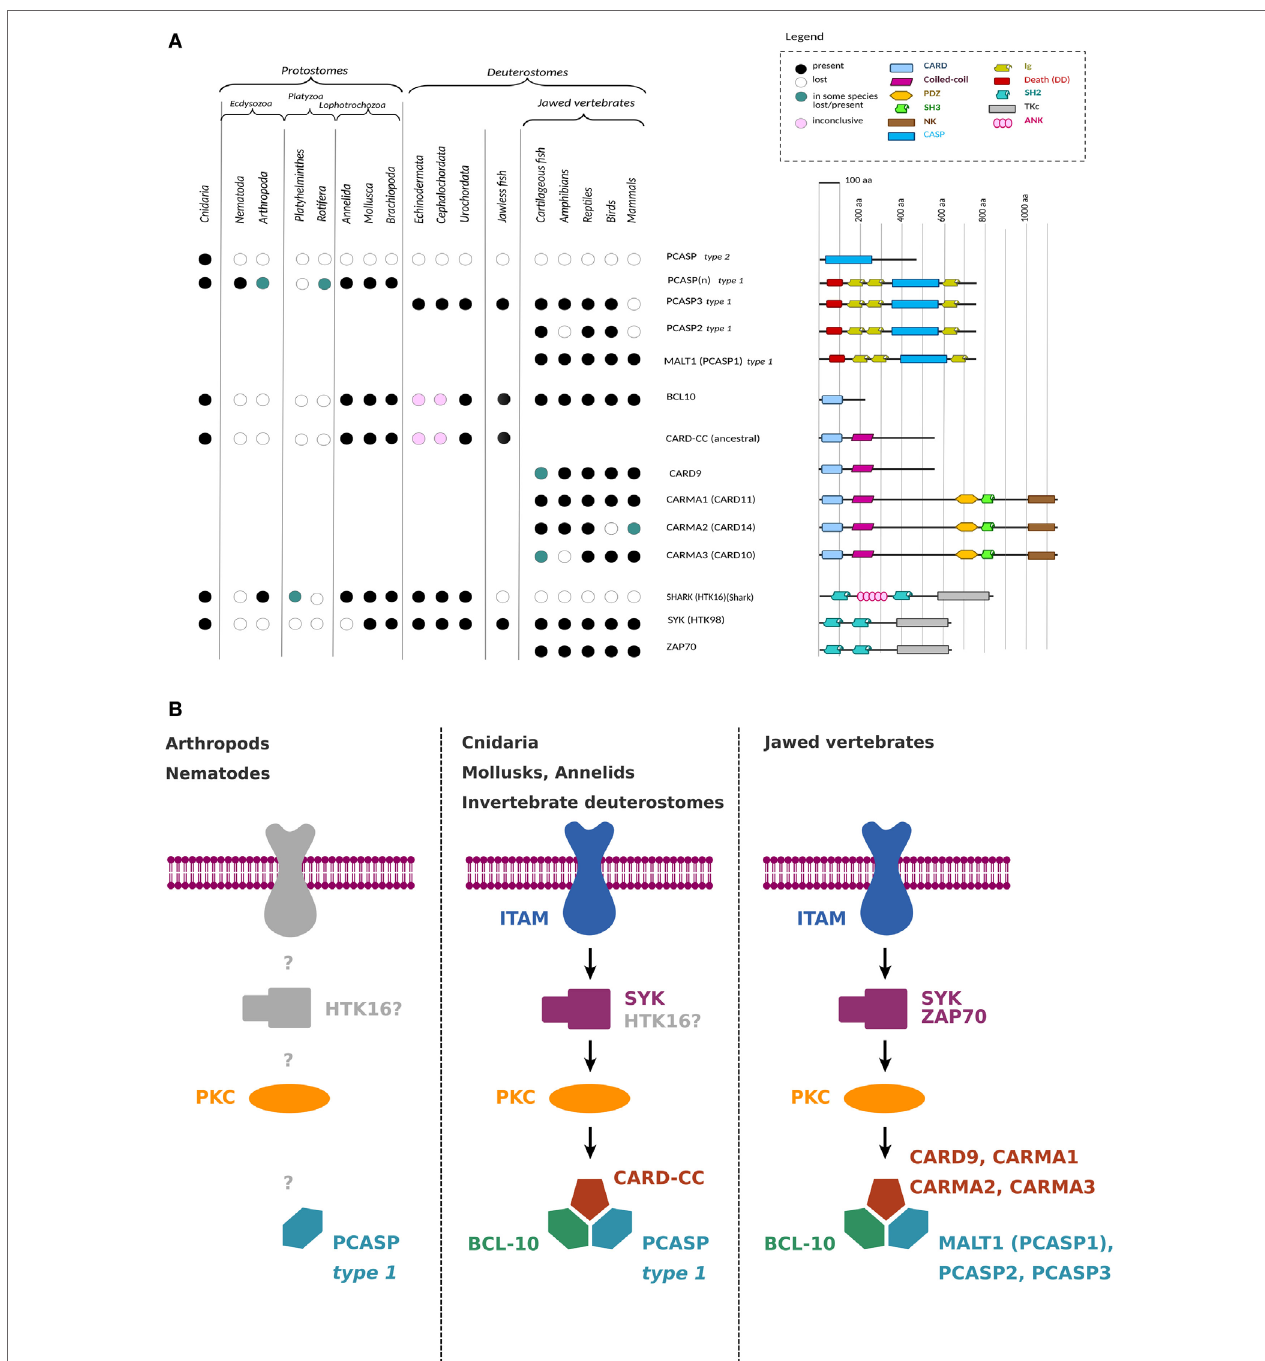
FigUre 1 | Coevolution and proposed signaling model. (a) Patterns of coevolution of Syk and several CBM complex components in various organisms within the planulozoan clade. Type 1 paracaspases prior to Deuterostomes were annotated as PCASP( n ) since currently available invertebrate genome sequences cannot determine whether a distant paracaspase is an ancient PCASP3 paralog or ortholog. One model proposes two ancient type 1 paracaspases, one Bcl10-dependent and one Bcl10-independent. The CARD–CC/Bcl10-dependent type 1 paracaspase shows MALT1-like activities. Deuterostomia (including tunicates, lancelets, vertebrates, and hemichordates), annelids, and mollusks inherited the Bcl10-dependent type 1 paracaspase, whereas most other bilaterian invertebrates kept the Bcl10-independent type 1 paracaspase. The model is based on currently available reliable sequence information and might change with additional data. Analogously, CARD–CC became duplicated and later fused with MAGUK domains in the jawed vertebrates. At this moment, we are uncertain about which of the four jawed vertebrate CARD–CC paralogs (CARD-9, -10, -11, -14) should be considered the ortholog of the ancestral CARD–CC. Also, upstream Syk became duplicated in jawed vertebrates, resulting in Zap70. (B) Proposed signaling model in various organism classes. Nothing is known about upstream activators of type 1 paracaspases in CARD–CC/Bcl10-independent organisms such as arthropods and nematodes.